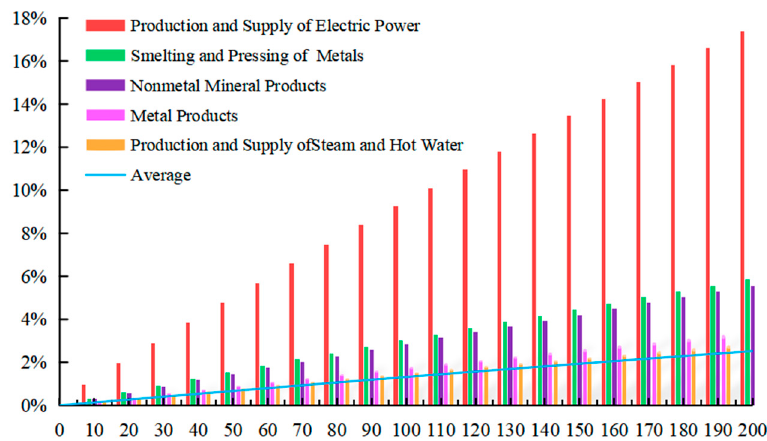
Figure 1. Relations of carbon tax and sectoral domestic products price.